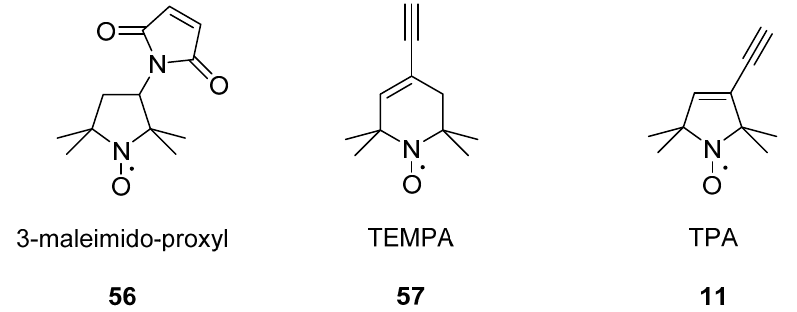
Figure 15. Spin labels used for in-cell DEER. The cysteine binding 3-maleimido-proxyl 9 , and nucleic acid base binding labels TEMPA 57 and TPA 11